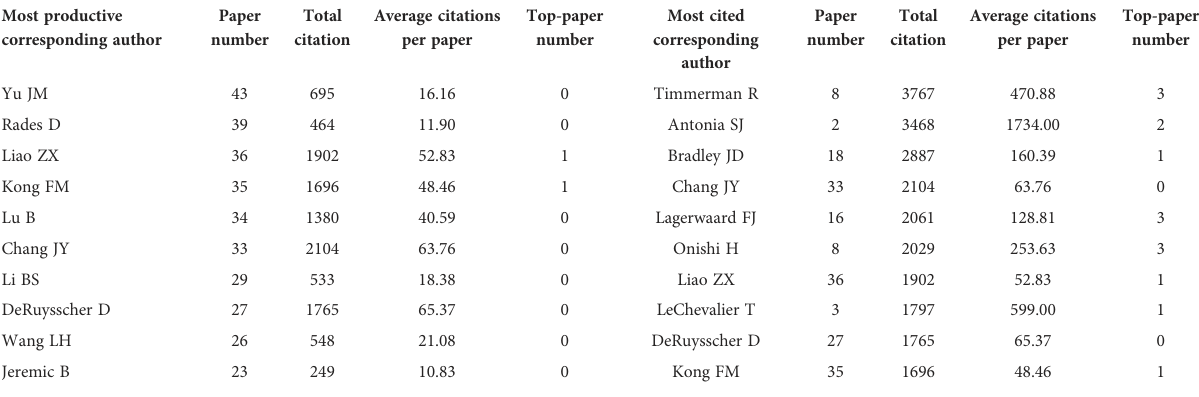
TABLE 7 The top 10 productive and cited corresponding authors in lung cancer radiotherapy from 2000 to